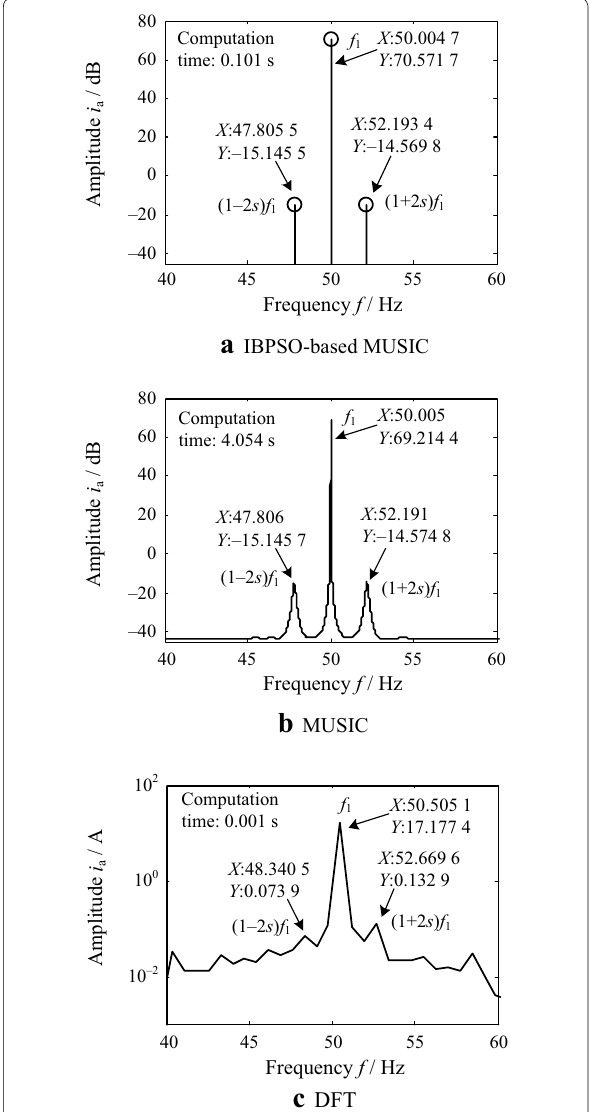
Figure 8 Spectrum analysis results of three algorithms at half‑load the results of three algorithms in Figure 8, IBPSO-based MUSIC has the best performance and low computation cost. (1) An improved BPSO (IBPSO) is proposed to make it more suitable for multimodal optimization prob- lem. Compared with SCGA and SPSO, the solu- tion quality and convergence speed are improved greatly.